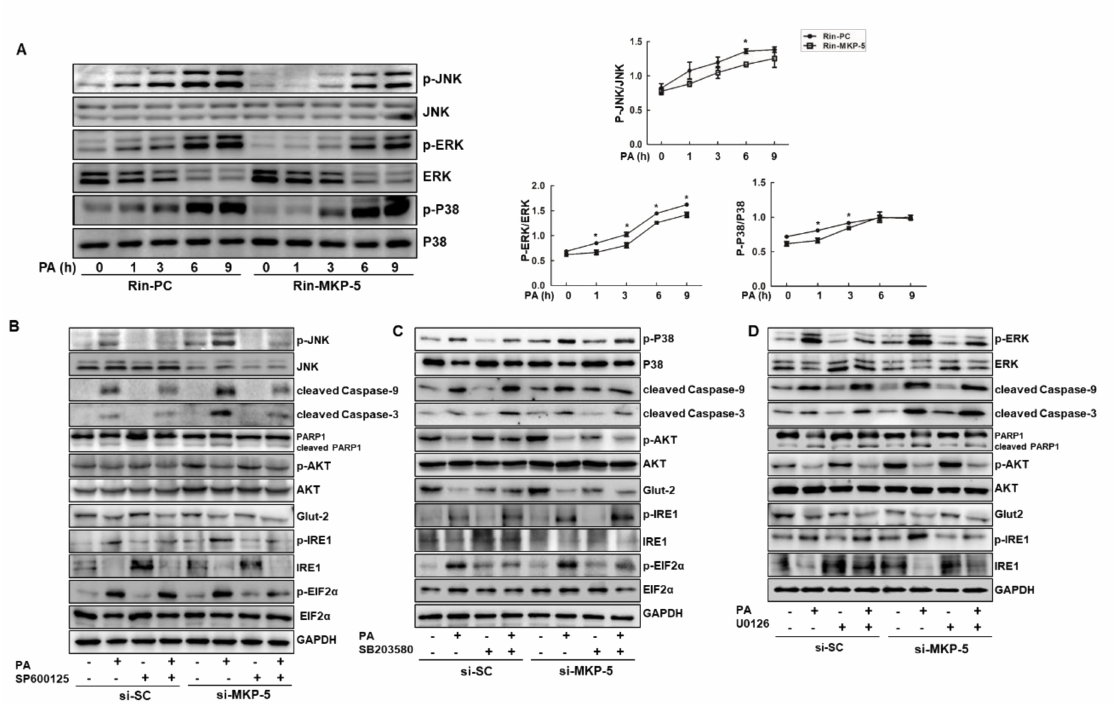
Figure 7. c-Jun amino-terminal kinase (JNK) and P38 are implicated in MKP-5-mediated regulation of Rin-m5f cell apoptosis and dysfunction in response to PA. ( A ). Rin-PC and Rin-MKP-5 cells were stimulated with PA for the indicated period of time, and then the levels of phosphorylated and total JNK, P38, and extracellular-regulated kinase (ERK) were detected by Western blotting. ( B ). Protein band intensity was quantified using the Image J software, and phosphorylated protein bands were normalized to their respective total protein levels. Rin-PC and Rin-MKP-5 cells were pretreated with SP600125 (50 µ M) ( C ), SB230580 (5 µ M) ( D ), or U0126 (5 µ M) for 1 h and then stimulated with corresponding inhibitor and PA for 9 h. The levels of MAPKs, apoptotic proteins, ERS-related proteins, and functional proteins were measured by Western blotting, and GAPDH was used as a loading control. All data are means ± SEM. *, p < 0.05, Rin-PC vs.